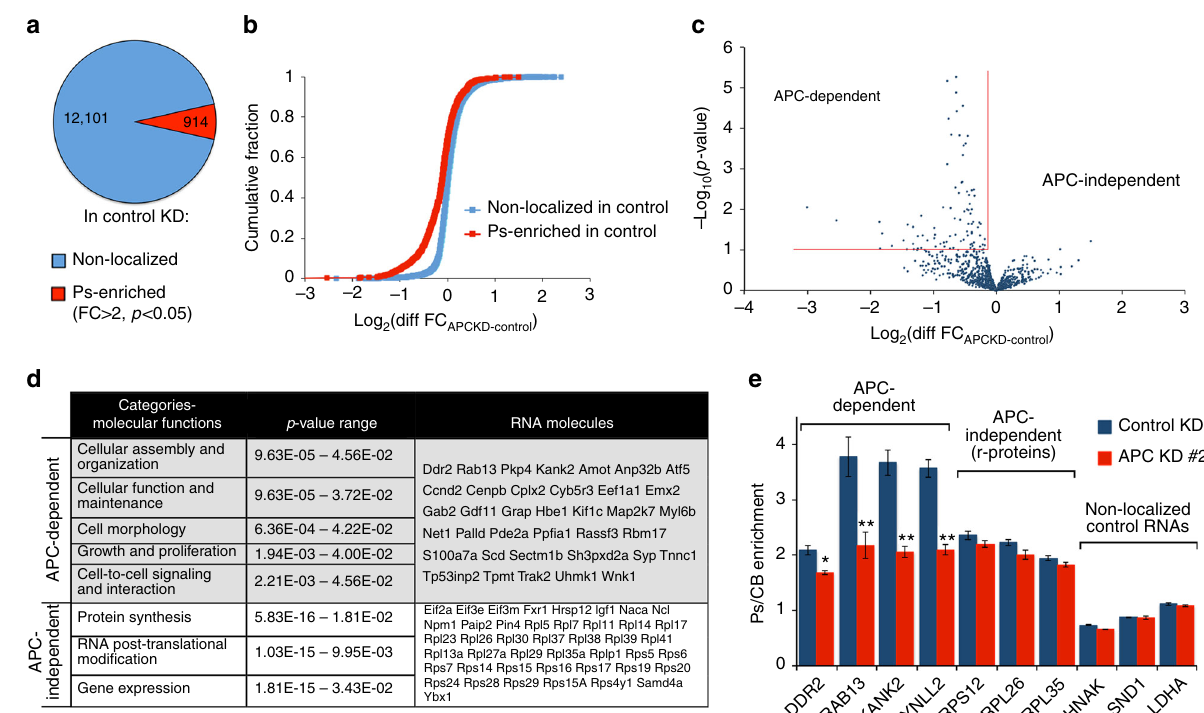
Fig. 1 Distinct RNA groups are targeted at protrusions through APC-dependent and APC-independent pathways. a Pie chart of non-localized or protrusion (Ps)-enriched RNAs in control knockdown (KD) cells from 4 replicate experiments. Cutoffs for Ps-enrichment were set at FC > 2 and p -value < 0.05. b Cumulative fraction plot of log2 fold-change differences between control and APC knockdown cells, for RNAs non-localized or localized in protrusions of control cells. c For all Ps-localized RNAs of control cells, the log 2 differences in FC values between control and APC knockdown cells were plotted against the corresponding p -values. Applying the cutoffs marked by the red lines (see Supplementary Data 1 for details), Ps-localized RNAs were distinguished into APC-dependent and APC-independent groups. d Categories of molecular functions, derived through IPA analysis, signi fi cantly represented in APC-dependent and APC-independent RNA groups. The identities of the RNAs included in the groups are listed. e Control or APC knockdown cells were fractionated into Ps and cell body (CB) fractions. The indicated RNAs were detected through nanoString analysis to calculate